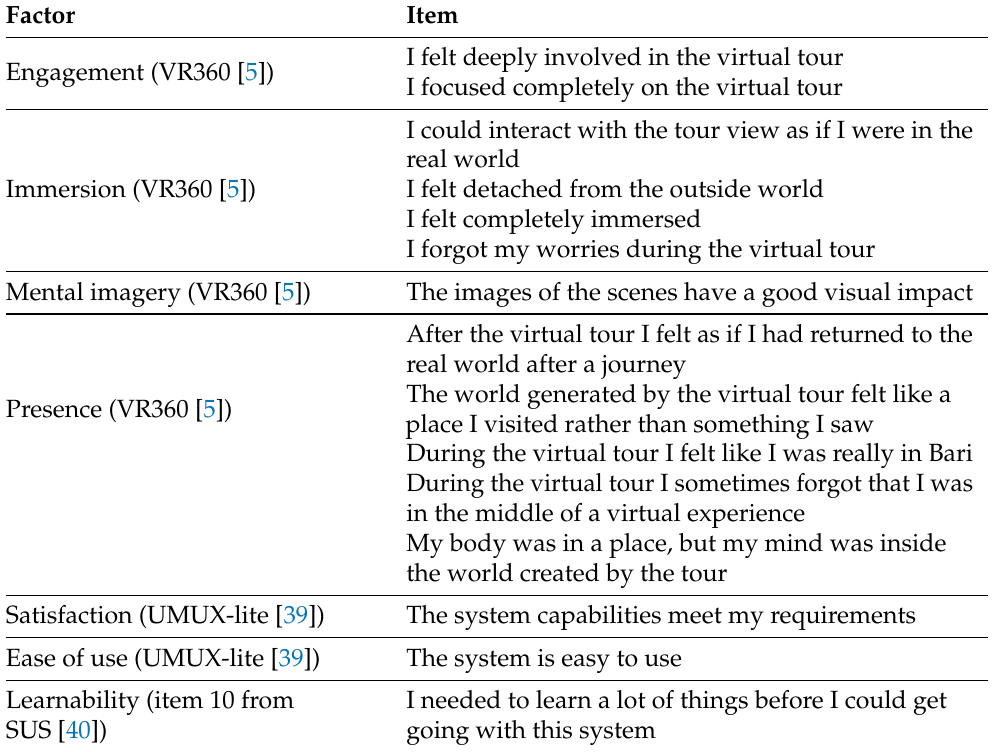
Table 1. Questionnaire for the evaluation of the user